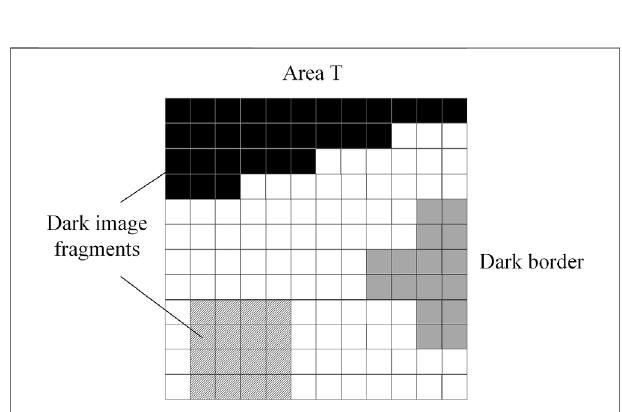
FIGURE 2 | Truncated median fi lter